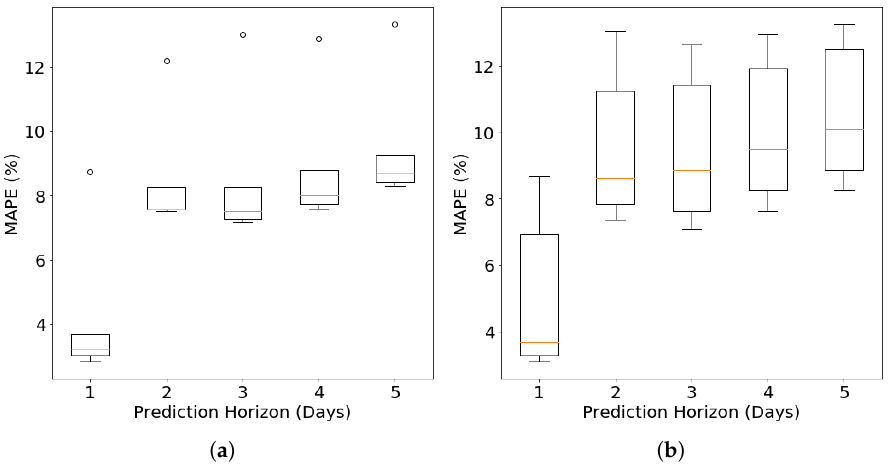
Figure 12. MAPE for forecasting a Y2E2 cooling load chilled water consumption using Squared Exponential Kernel and Matern Kernel. ( a ) Squared Exponential Kernel; ( b ) Matern Kernel.